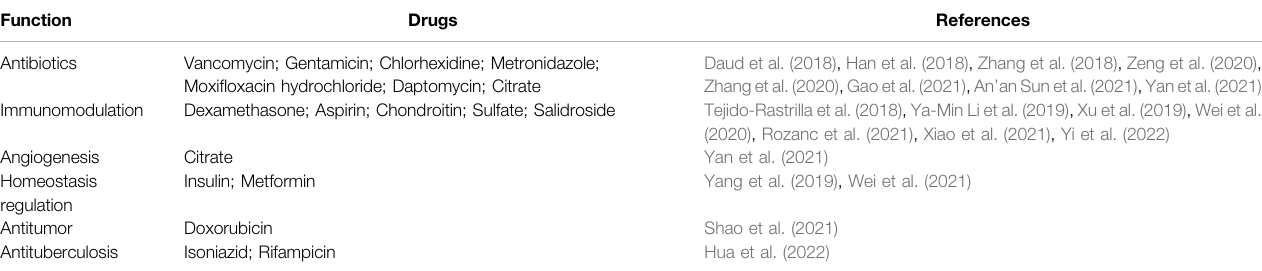
TABLE 3 | Drugs applied in PDA-based multifunctional